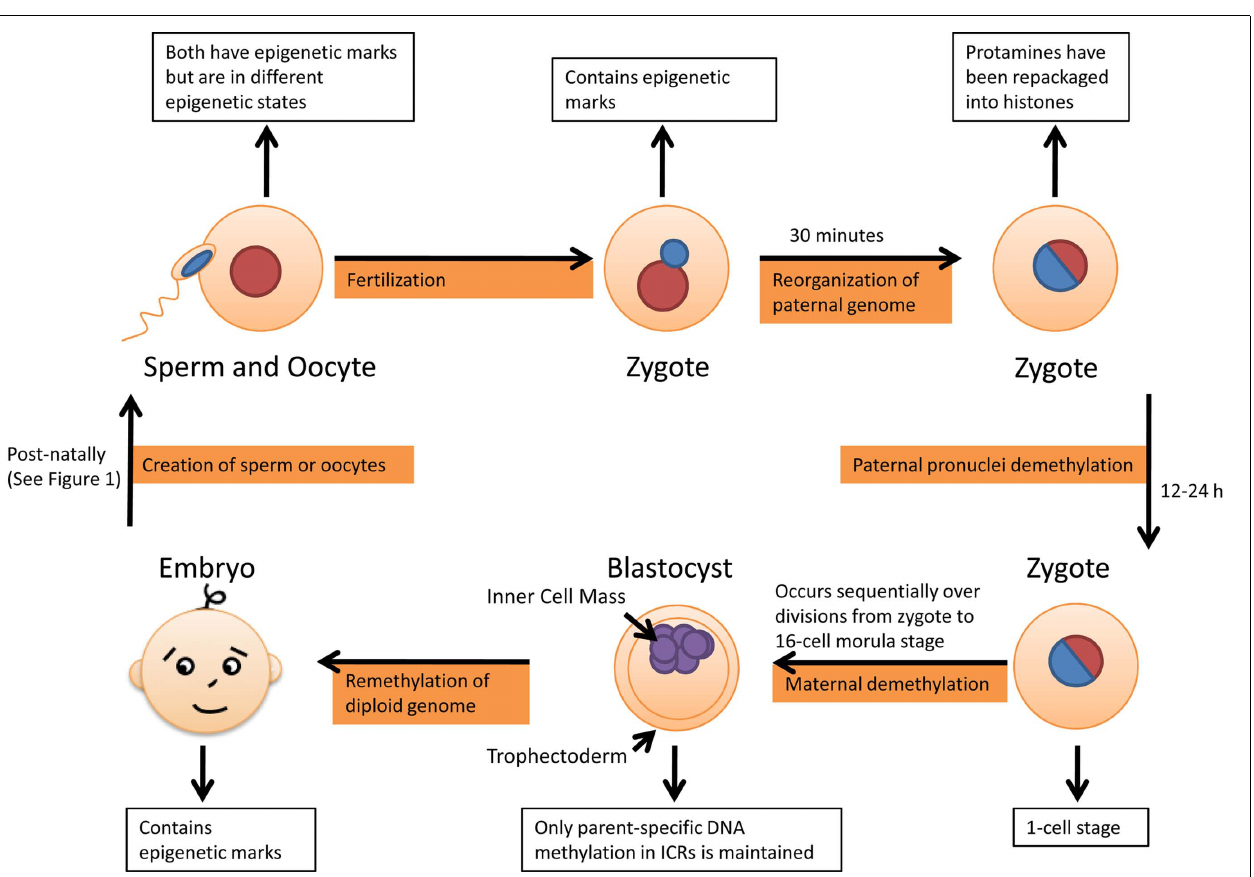
FIGURE 2 | Second round of epigenetic reprogramming occurs following fertilization sequentially from zygote to morula stage, remethylation occurs only in inner cell mass, the mass of cells which eventually gives rise to the definitive structures of the